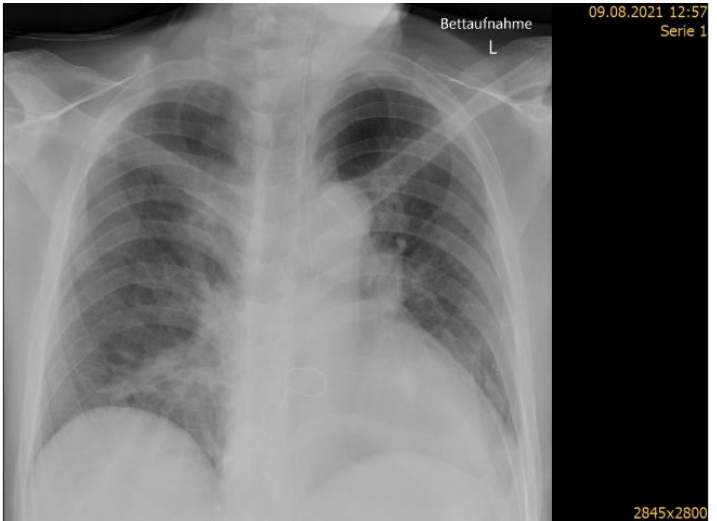
Figure 2. Chest X-ray showing signs of hospital acquired pneumonia (right middle lobe